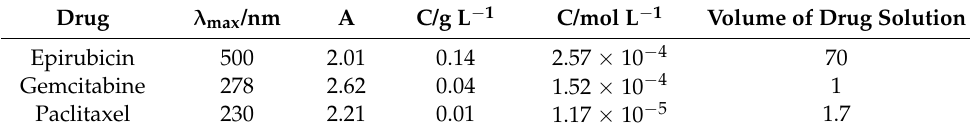
Table 6. Spectral parameters and quantitative values calculated for each drug.